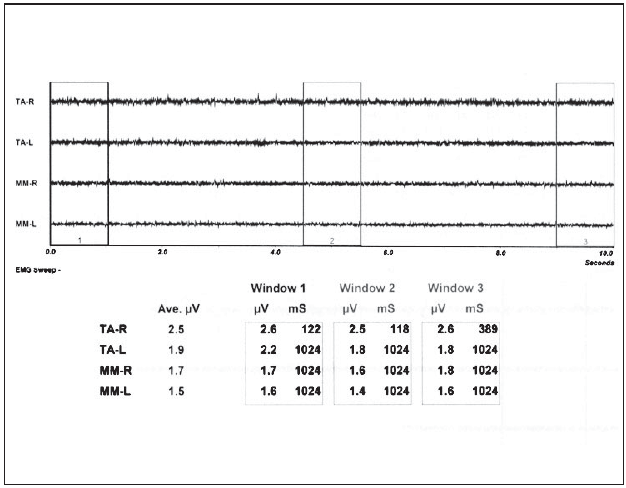
Fig. 2. EMG tracings obtained acquisition values before the application of the LLLT for right and left temporal muscles (TA-R and TA-L, respectively) and for right and left masseter muscles (MM-R and MM-L, respectively) 5 min after LLLT. statistically significant difference between the EMG activity before and immediately after LLLT application ( P